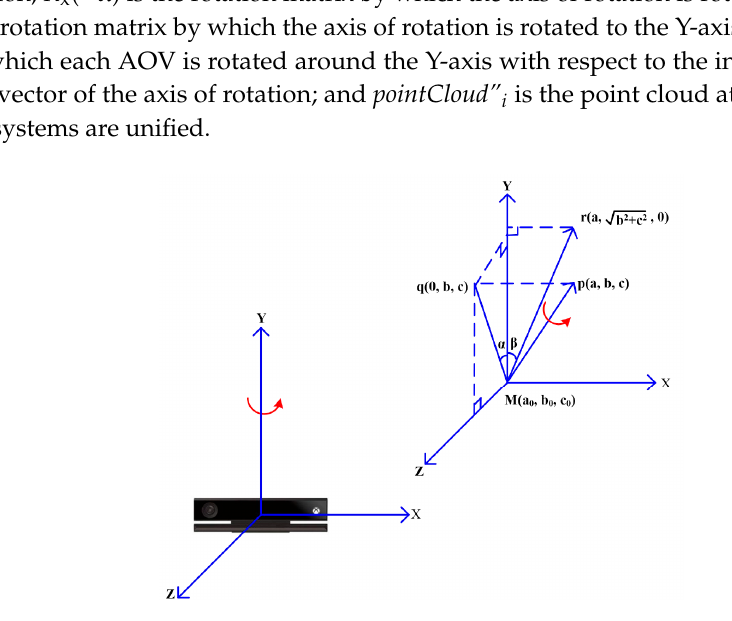
Figure 3. Schematic diagram of the unification of multiview point cloud coordinate systems.